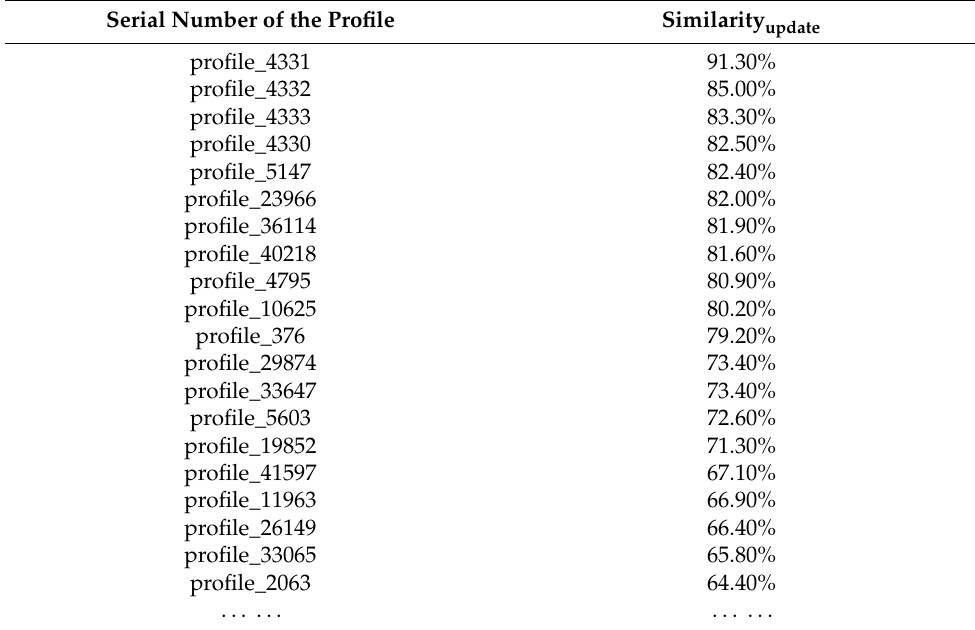
Table 2. Similarity matching results for 10 m interval topographic profiles sequence(partial).